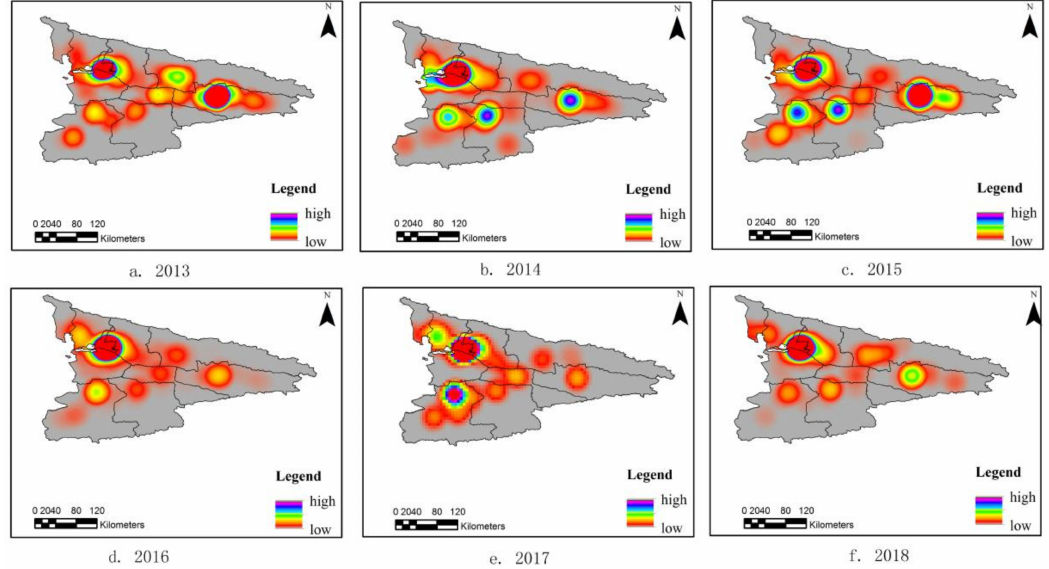
Figure 1. Kernel density maps for hand-foot-and-mouth disease (HFMD) from 2013 to 2018. (( a ). 2013, ( b ). 2014, ( c ). 2015, ( d ). 2016, ( e ). 2017, ( f ).